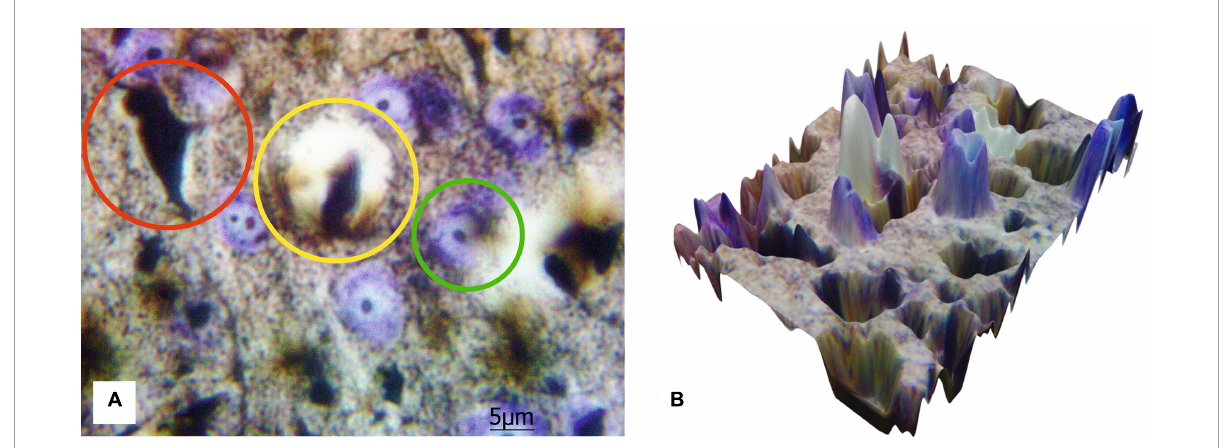
FIGURE5 The 2D image of rat motor cortex (A) with the highlighted protoplasmic astrocyte and the vessel (yellow circle), impregnated neurons (red circle), and neurons stained with cresyl violet (green circle). Ob. 100x, oc. 20x; (B) corresponding 3D surface for the 2D histological image of the same histological section.